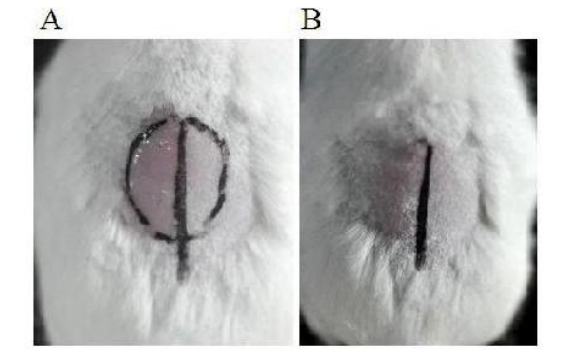
Figure 4. Gross appearance of skin from control and rgVEGF164- treated sides of mice. After 3 weeks, rgVEGF164-treated animals displayed quick hair regrowth. Right side is rgVEGF164-treated side and left side is control. VEGF, vascular endothelial growth factor; rgVEGF164, recombinant goat